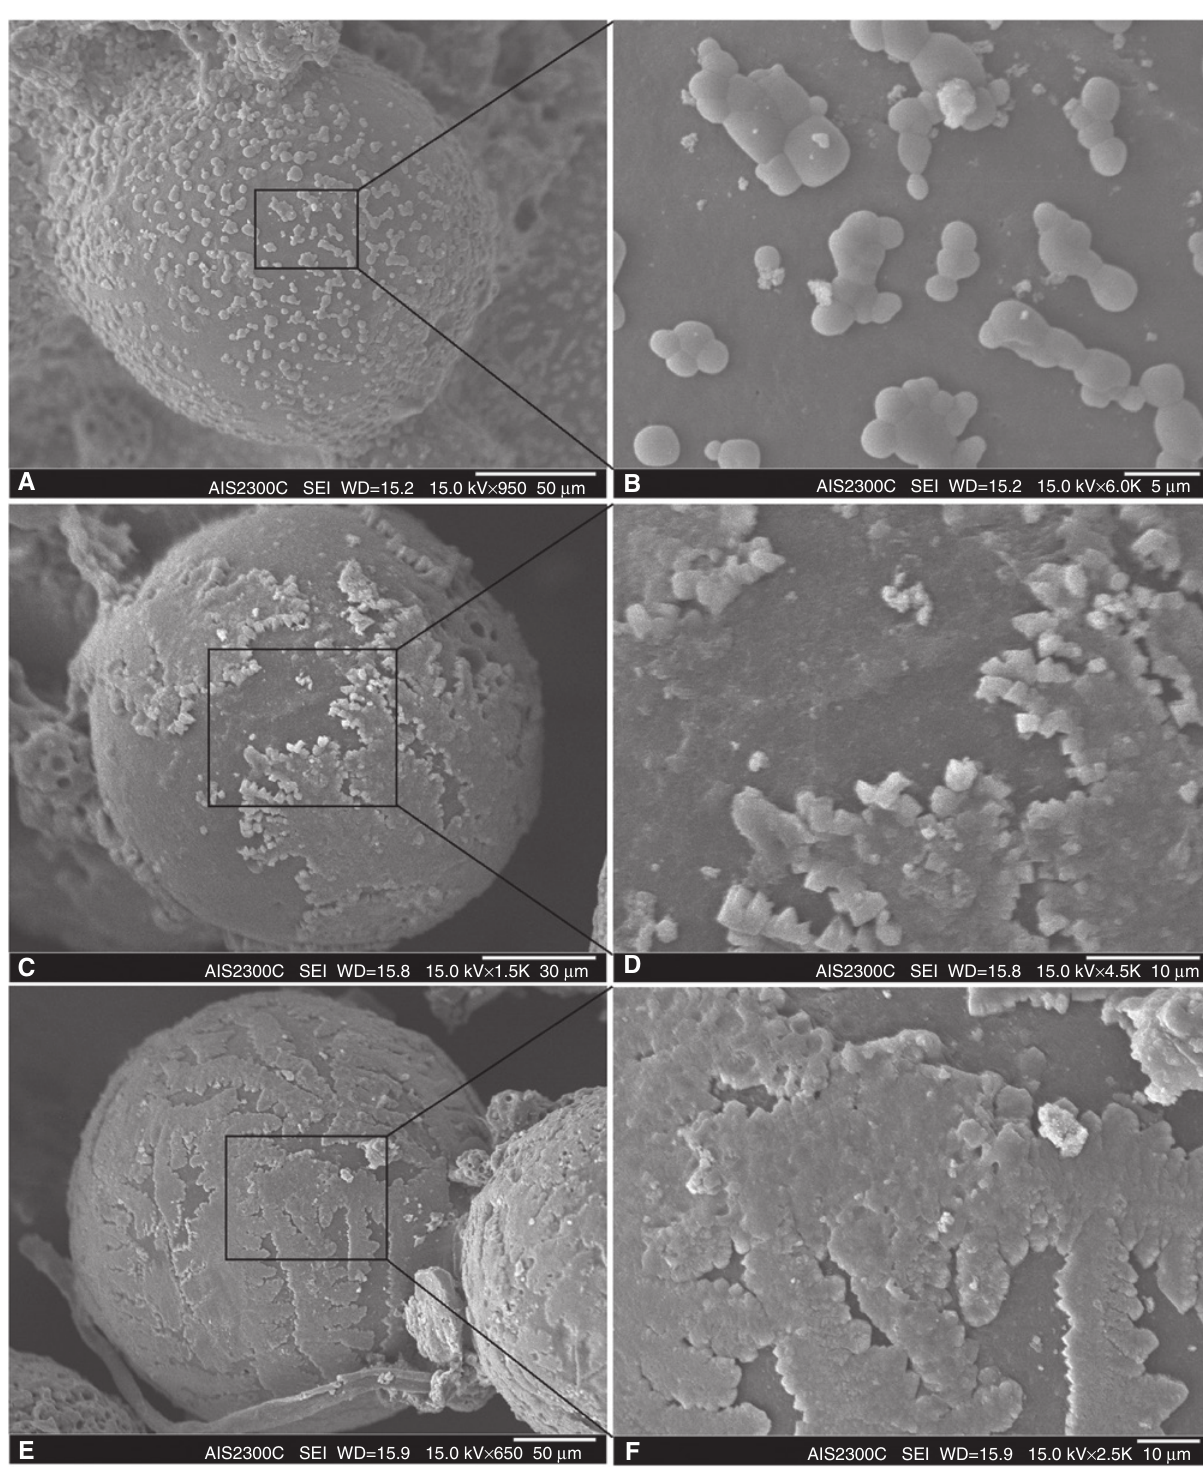
Figure 6 SEM micrographs of the composite scaffold surface after immersion into SBF: (A and B) after 1 day in SBF, (C and D) after 7 days in SBF, and (E and F) after 14 days in